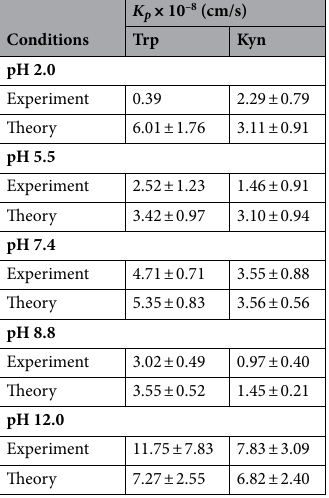
Table 2. Experimental and theoretical Trp and Kyn permeability constants ( K p ). The theoretical calculations were obtained according to the four permeation pathways theory (see Supplementary Information); n = 6, except for pH 5.5 where n = 5).